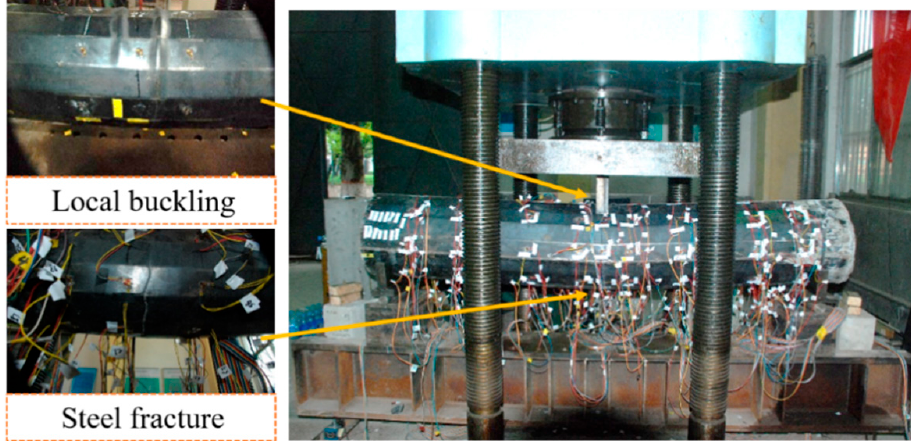
Figure 5. Failure modes of CFHST